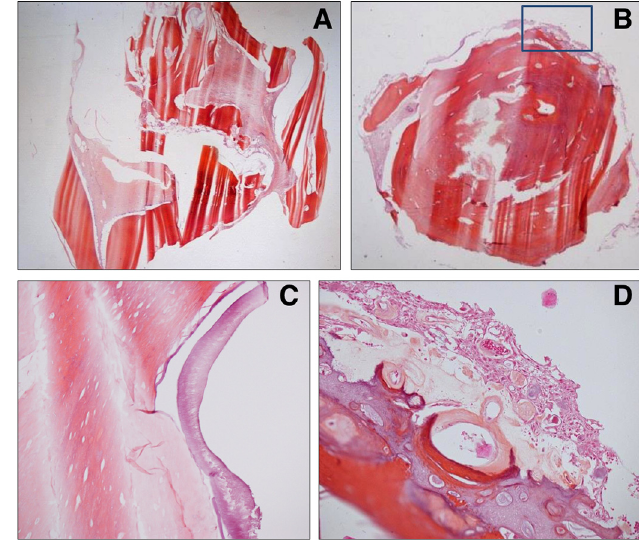
Fig. 6. Microscopic histological fi ndings of the lesion. (A and B) HES, magni fi cation (cid:1) 10. A tubular dentin-type mineralized tissue associated with focal enamel-like mineralized tissue is surrounded by a non-mineralized pulpal-type tissue coated with its odontogenic epithelium. Blue square labeled corresponds to the area shown in Figure 6 (D). (C) HES, magni fi cation (cid:1) 200. An eosinophilic tubular dentin-type mineralized tissue associated with a more basophilic enamel-like mineralized tissue. (D) HES, magni fi cation (cid:1) 200. An odontogenic epithelium is found focally. Some ghost cells and dystrophic calci fi cations are present.